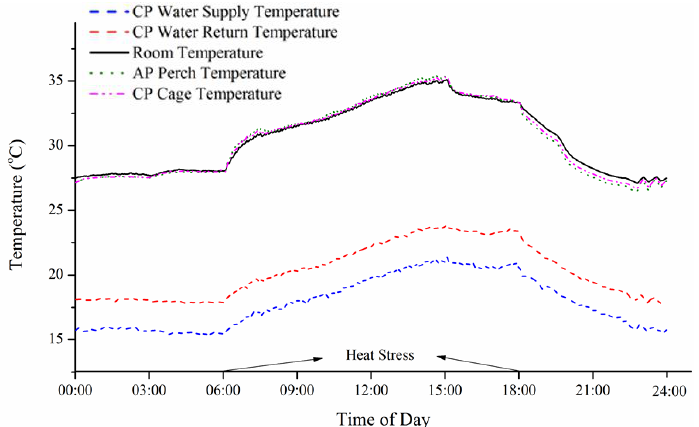
Figure 2. An example of temperatures recorded for 24 h during a heat episode (0600 to 1800 h). Notes: Supply/return temperatures maintained a 2–3 ◦ C difference. Return temperature was warmer than supply temperature. Ap, air perch; CP, cooled perch; and NP, non-perch. Copied from [43].